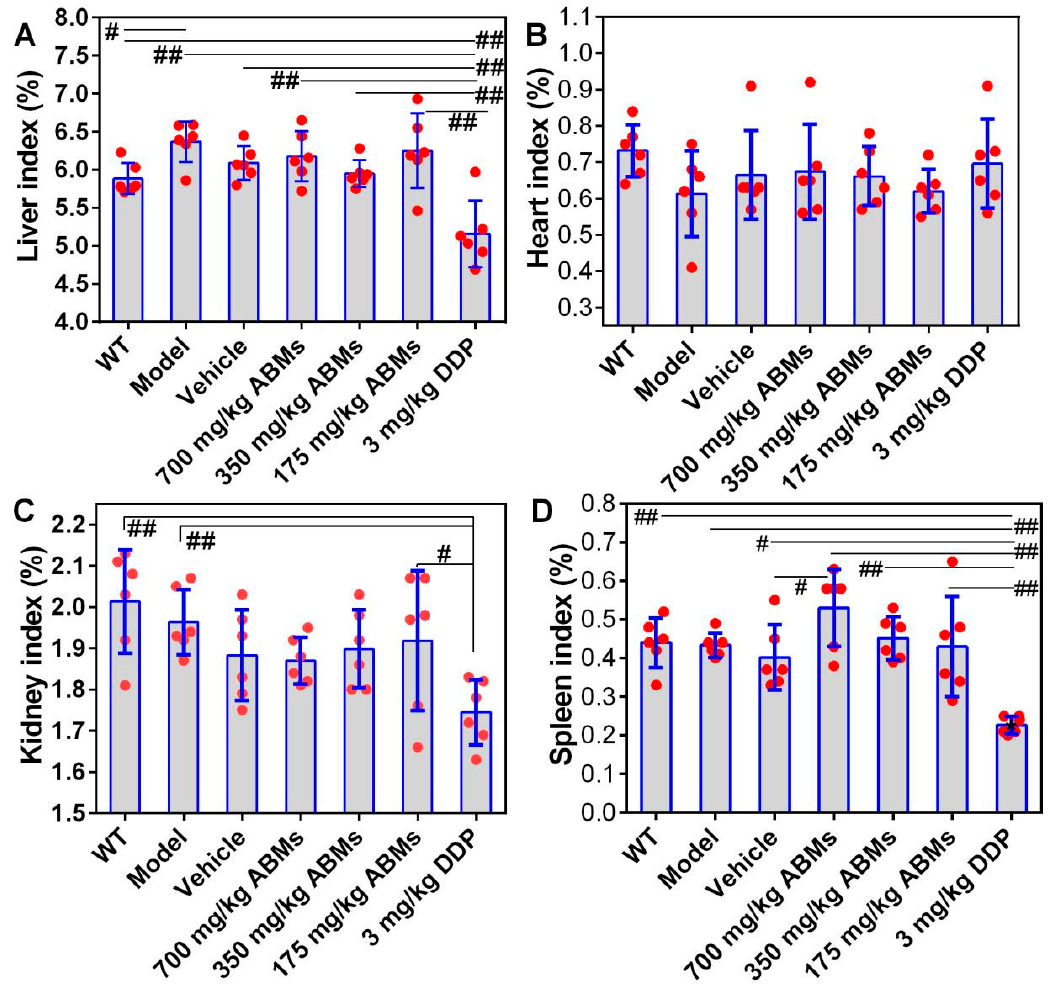
Figure 9. Statistical analysis of organ indexes of tumor-bearing mouses. ( A ) liver; ( B ) heart; ( C ) kidney; ( D ) spleen. Note: # p < 0.05, ## p ≤ 0.01. All numerical results were denoted by mean and SD.